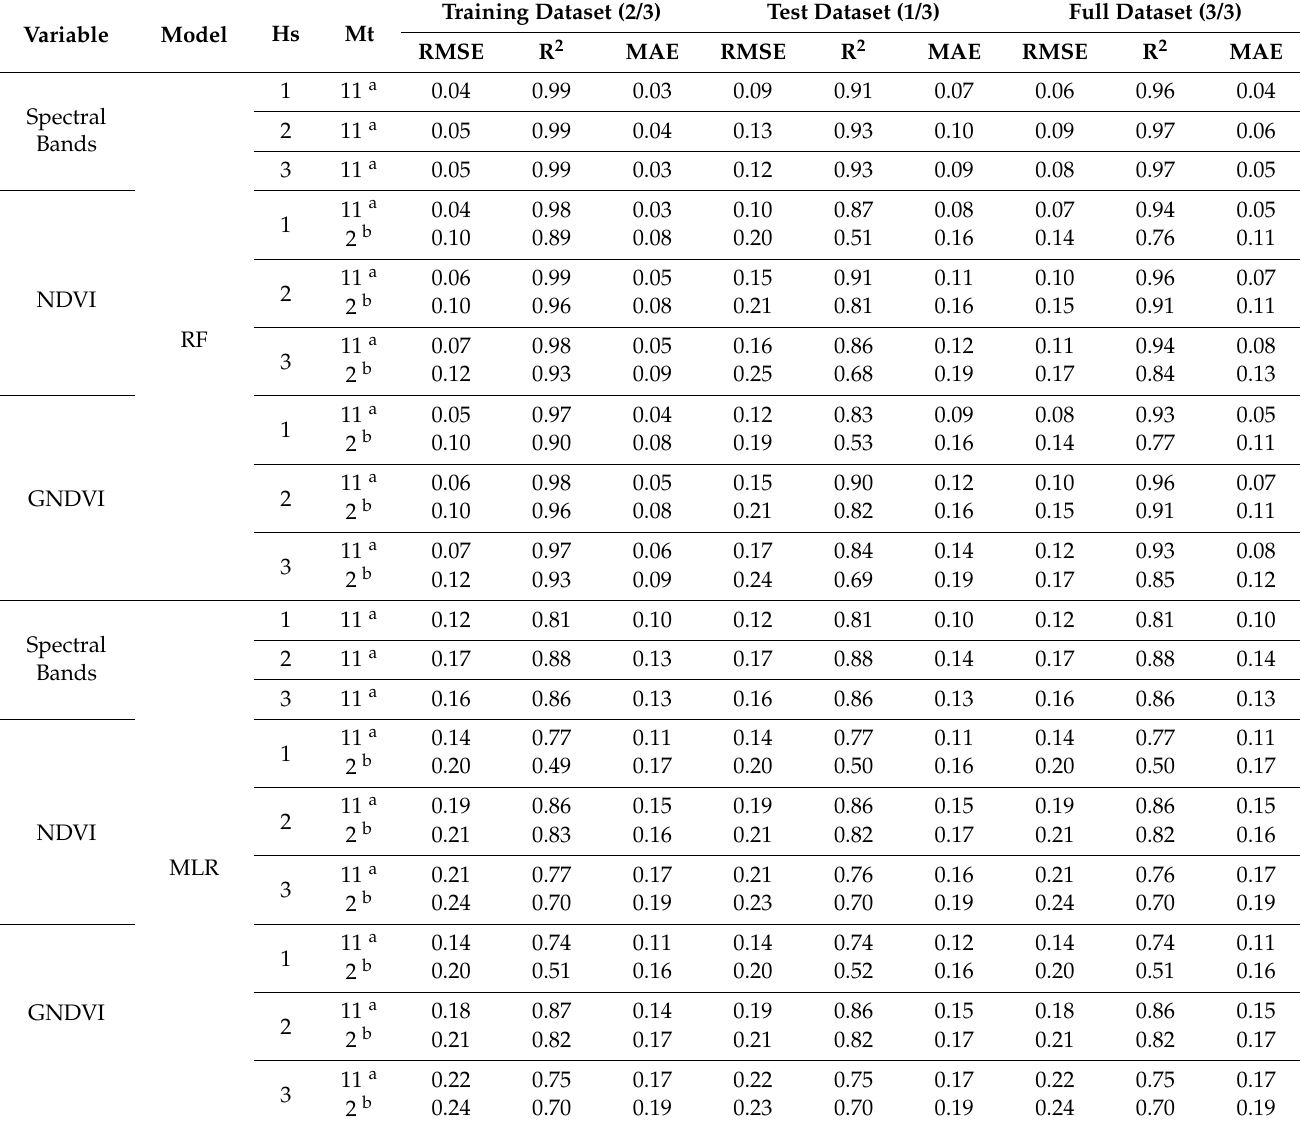
Table 2. Mean squared error (RMSE), coefficient of determination (R 2 ), mean absolute error (MAE) results for training, test and the entire dataset, applying random forest and multiple linear regression to predict coffee yield based on different types of variables and months within